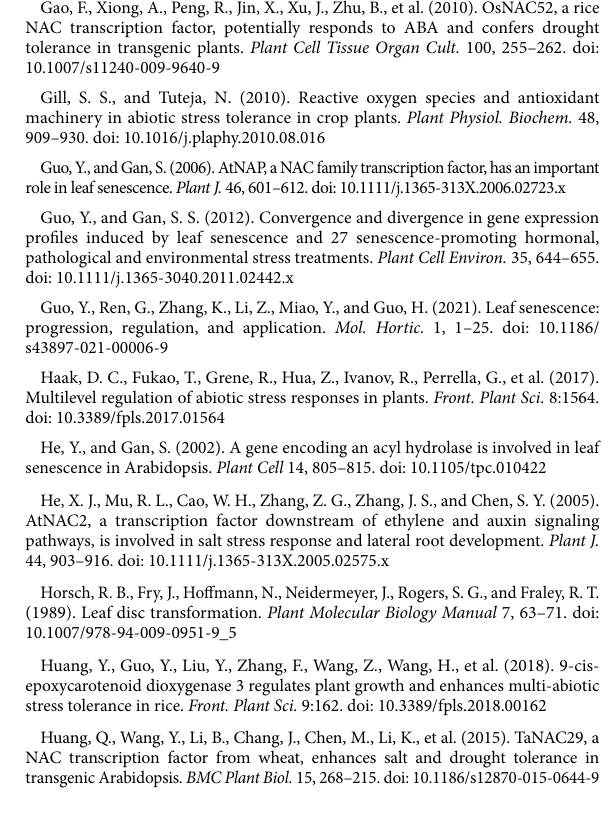
SUPPLEMENTARY FIGURE S1 Overexpression of NtNAC028 in Arabidopsis plants causes precocious senescence. SUPPLEMENTARY FIGURE S2 Seed germination under salt treatments. SUPPLEMENTARY FIGURE S3 Seed germination under ABA treatments. SUPPLEMENTARY FIGURE S4 Expression patterns of reactive oxidation species scavenging-related genes in WT and NtNAC028-OE plants in response to salt and drought treatments. SUPPLEMENTARY FIGURE S5 Expression patterns of stress responsive genes in WT and NtNAC028-OE plants under salt and drought treatments. SUPPLEMENTARY FIGURE S6 Expression patterns of ROS scavenging-related genes in WT and ntnac028 plants in response to salt and drought